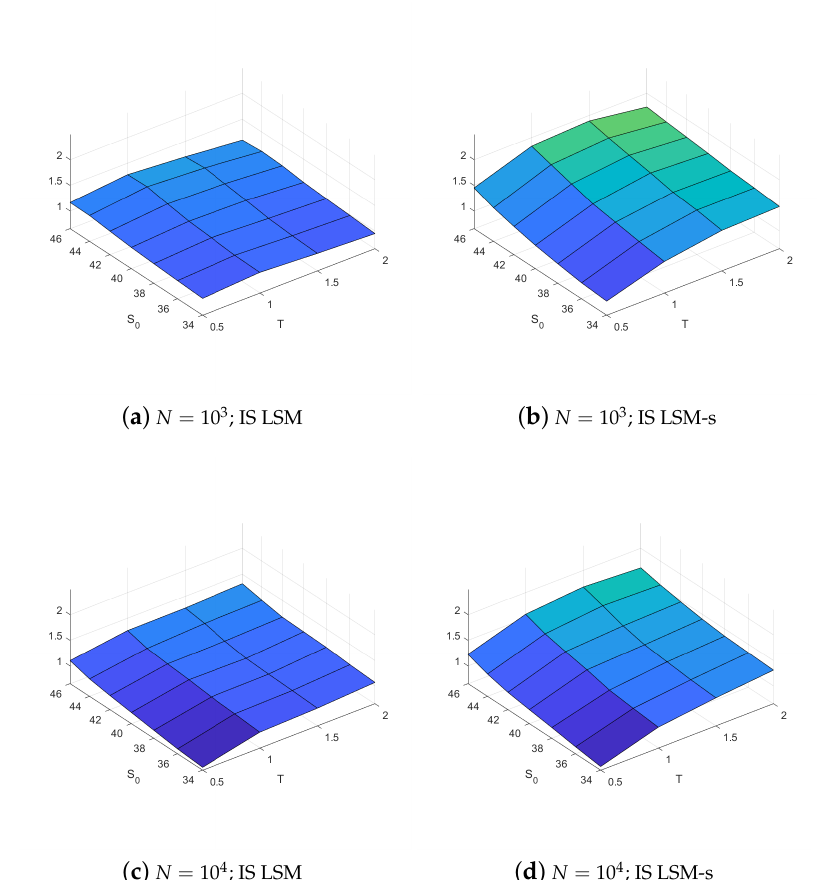
Figure 8. RMSE efficiency with GHS drift. RMSE efficiency results are calculated from a sample of R = 10 7 / N replications of the LSM and the LSM-s estimators. The left column illustrates results for the LSM without importance sampling, the center column LSM with importance sampling, and the right column LSM-s with importance sampling. The top row presents results for estimators using 1000 paths and the bottom row for 10,000